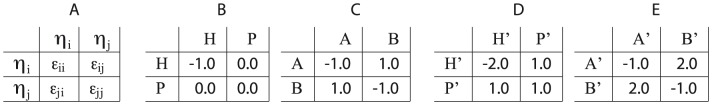
Potentials for the canonical HP and AB models.(A) General structure of a binary potential, composed of monomers  and . Potentials of the HP model (B), AB model (C), HP shifted (D), AB shifted (E).